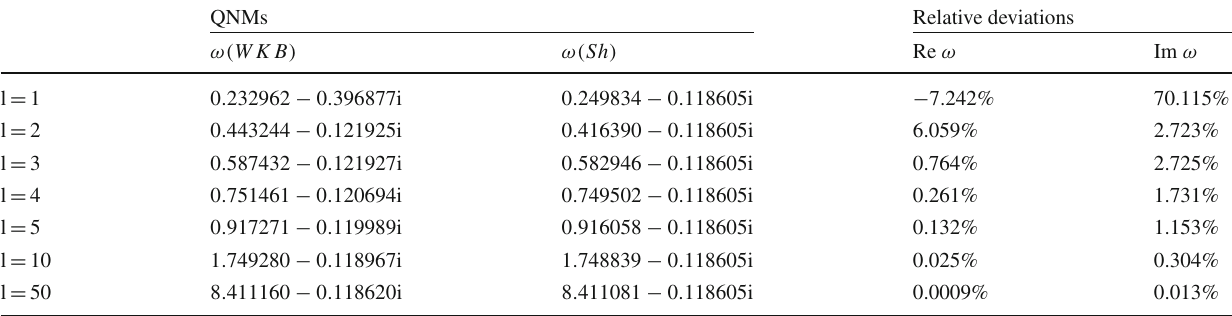
Table 2 The QNMs derived by the WKB approximation approach and shadow radius and the relative deviations. In the calculation, we let Q = 0 . 1